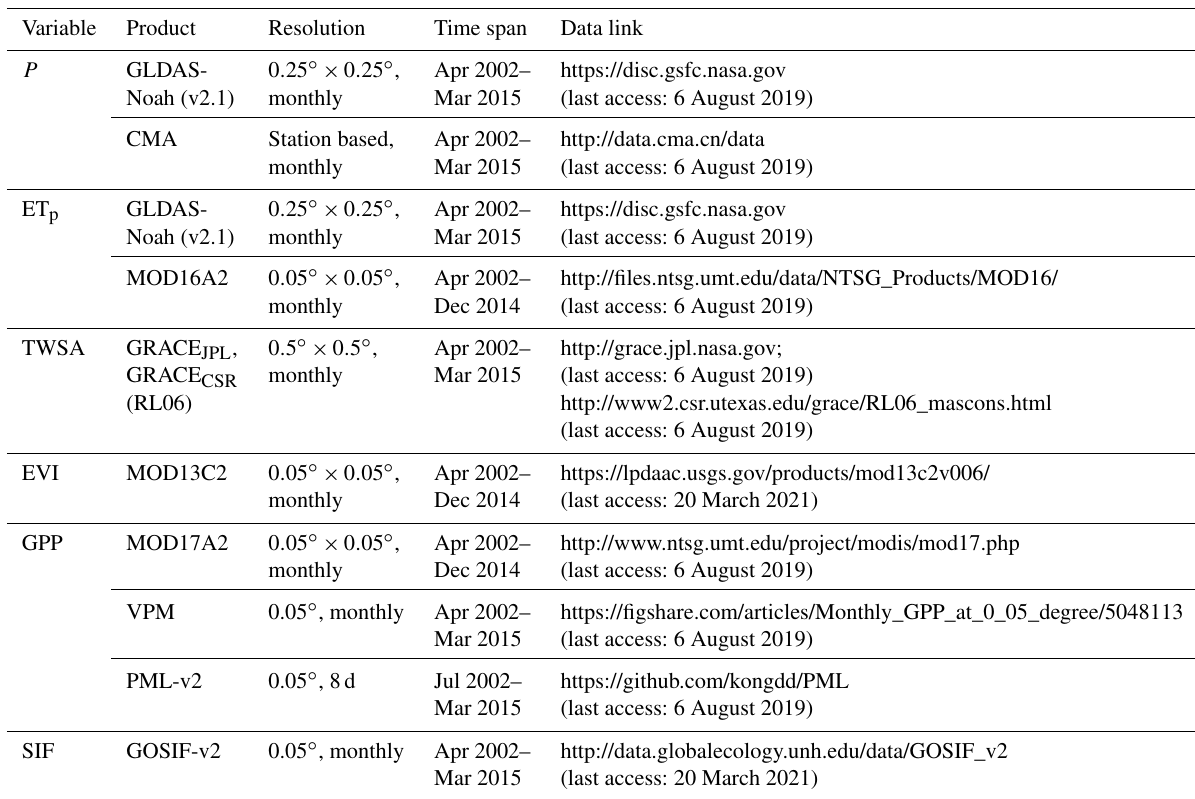
Figure 1. (a) The Pearl River basin and the related provinces on a map of the China. (b) Digital elevation map (meters above sea level – ma.s.l.; 1000m resolution). (c) Land cover types (30m resolution). Table 1. Information of data used in this